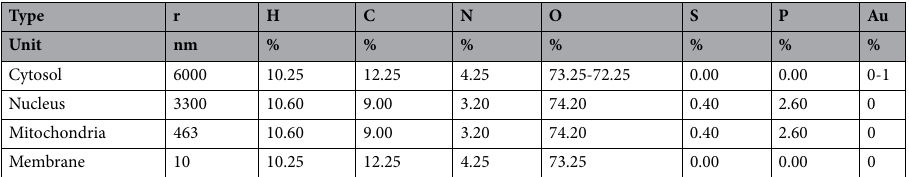
Table 2. Geometrical parameters of CHO cells. The dimensions of cytosol, nucleus and mitochondria are given as radius. The membrane thickness is listed as diameter 59 . The chemical composition of the different parts of the cell is given in mass percent and density of 1.0 g/cm 360 Ninety mitochondria were simulated 57